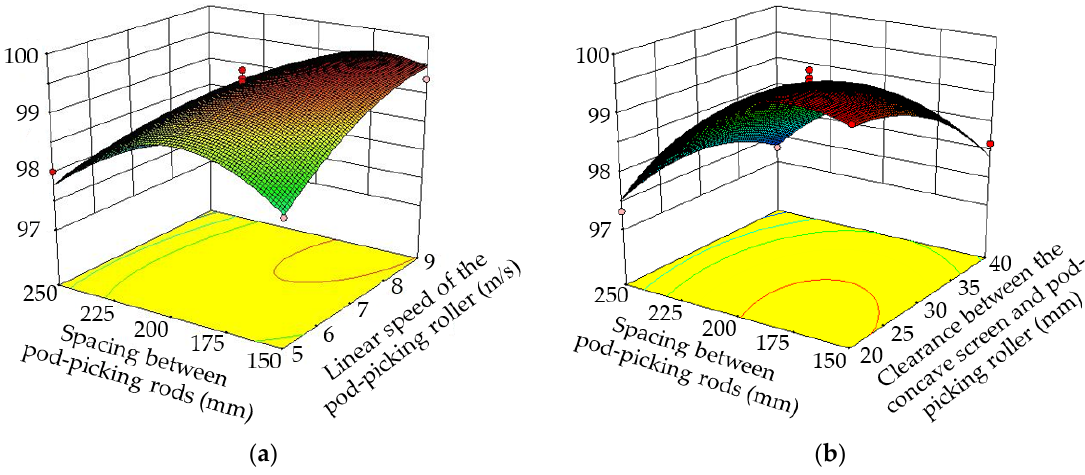
Figure 9. Dual-factor response surfaces of pod-picking performance indicators. ( a ) Y 1 , G = 3 mm. ( b ) Y 1 , V = 7 m/s. ( b ) Y 1 , V = 7